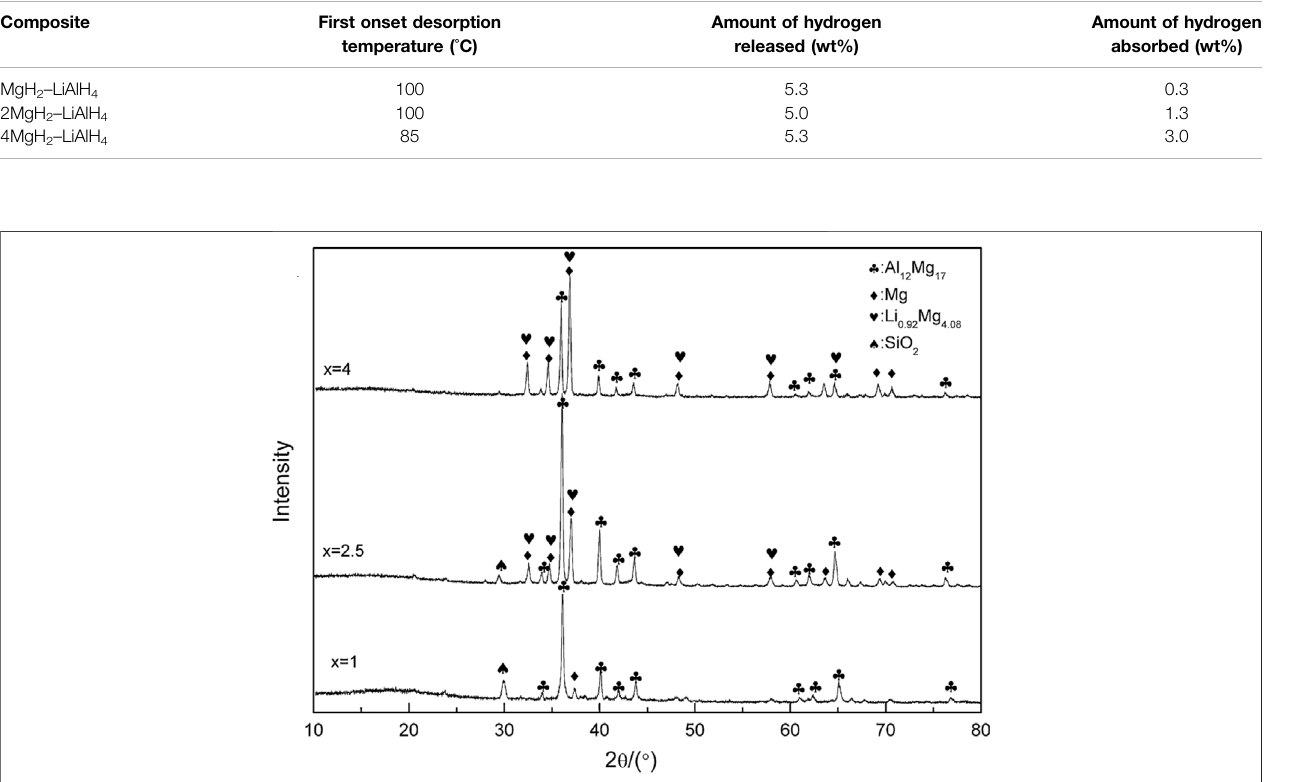
Frontiers in Energy Research |